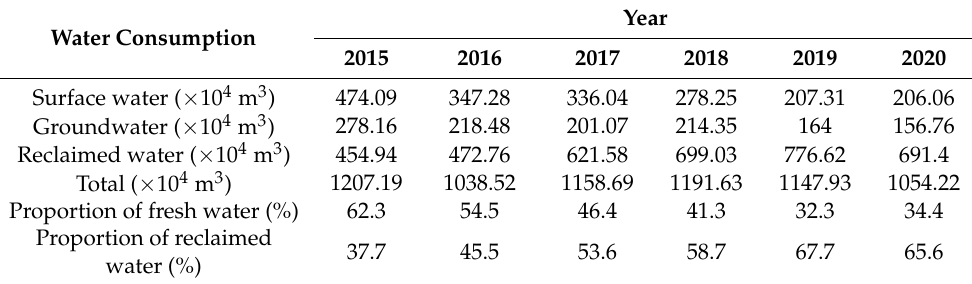
Table 2. Water source in the study area from 2015 to 2020.